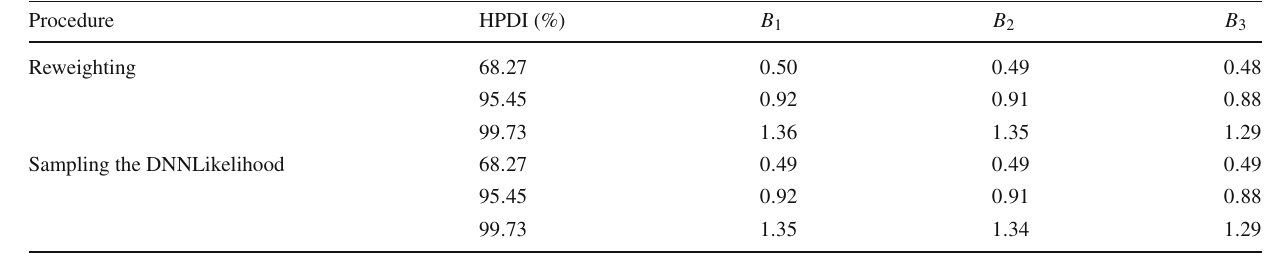
Fig. 11 Same as Fig. 9 but for the DNNLikelihood B 3 Table 3 HPDI obtained from the different DNNLikelihood models B 1 − B 3 both by reweighting on the test set of S 1 (upper block) and by re-sampling (lower block). Results are only shown as upper bounds on